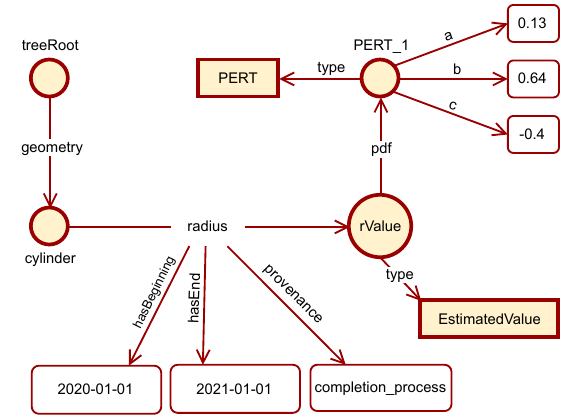
Figure 4. Example of a tree root object with cylindrical geometry. It has an estimated radius defined by a PERT distribution and only valid within the defined time interval.